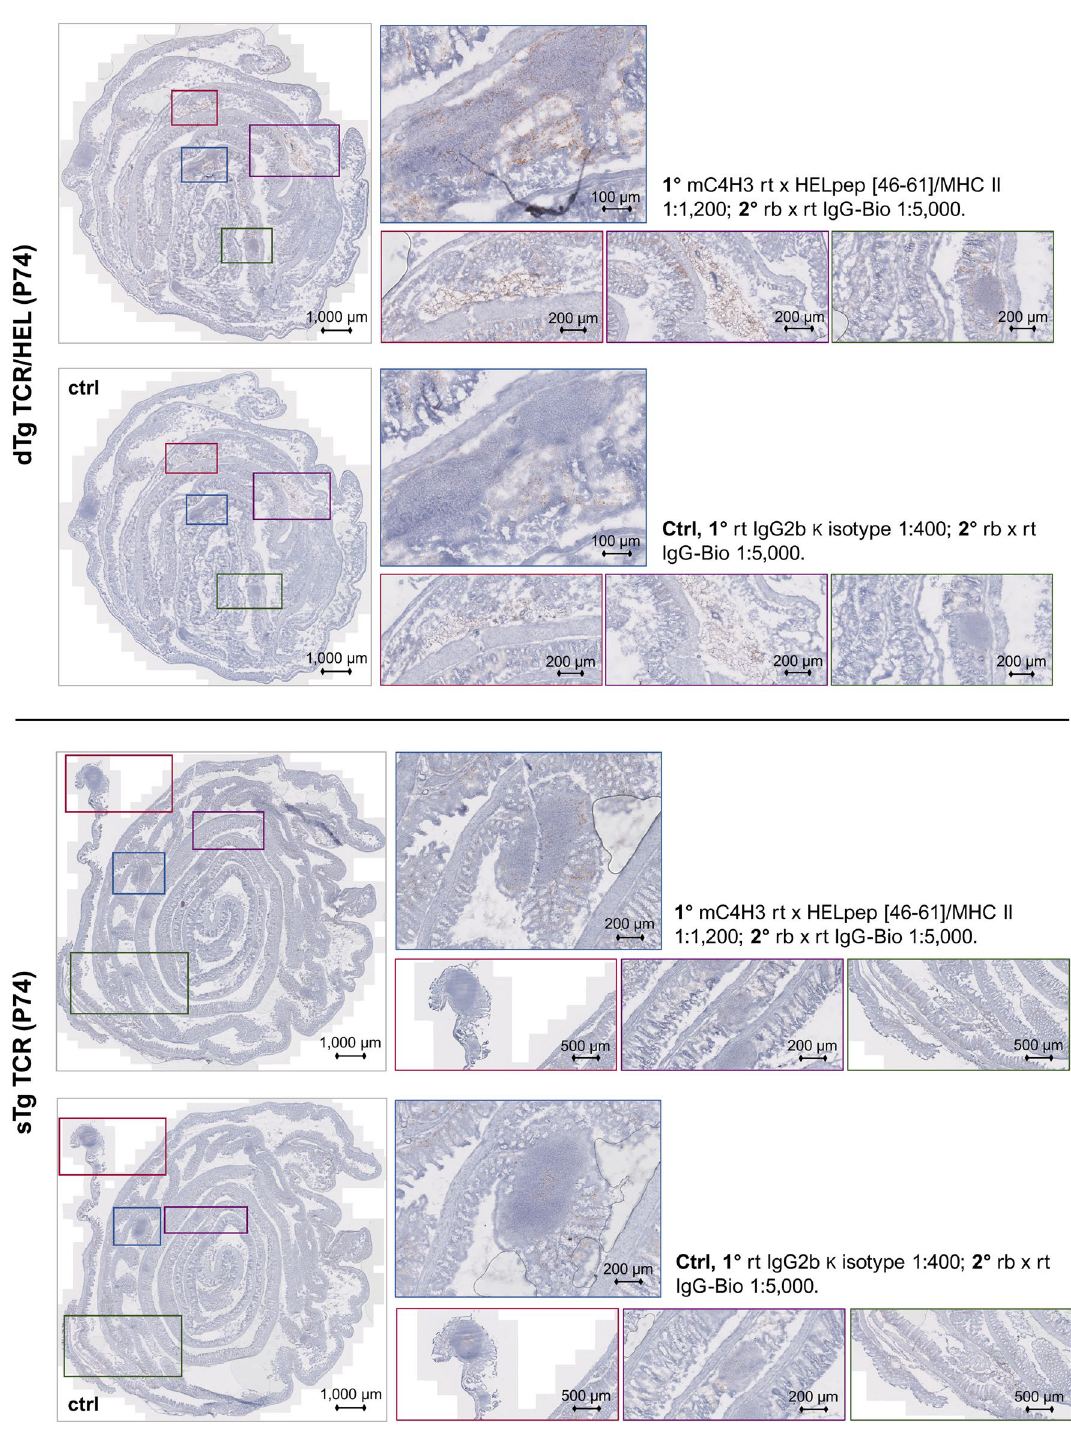
Figure 6. MHCII-HEL complexes are exclusively present in colon of dTg mice. The monoclonal C4H3 rat anti- chicken antibody towards HEL peptide [46–61] was used to histologically stain MHCII-HEL complexes in colon Swiss roll sections. Sections were counterstained with Haematoxylin QS (Vector Laboratories, 2BScientific, UK). Top panel: P74 section from dTg mouse; note positive brown staining particularly in and around granulomas and erupting Peyer’s patches vs. control. Bottom panel: staining was performed using sTg TCR colon sections. Only faint background staining was found in either sTg TCR test conditions. Note: Unavoidable faint background staining results from the intrinsic abundance of inflammatory cells in the lamina propria. Per genotype group n = 3 sections were independently stained across three